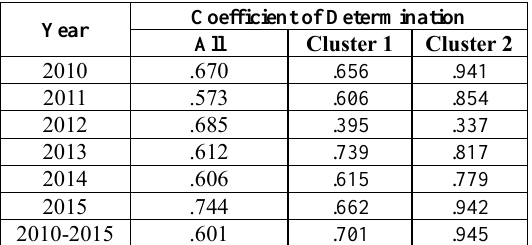
Table 3. Coefficient of determination for the whole Quezon City, Cluster 1 and Cluster 2 in each year and whole period